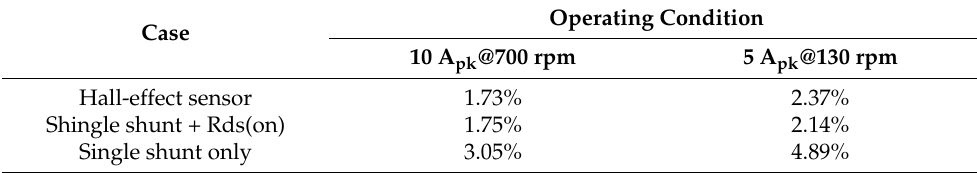
Figure 13. ( a ) 700 rpm@10 A pk Hall-effect sensor vs. single shunt + Rds(on) control current waveform; ( b ) 130 rpm@5 A pk Hall-effect sensor vs. single shunt + Rds(on) control current waveform. Table 4. Total harmonic distortion of current.